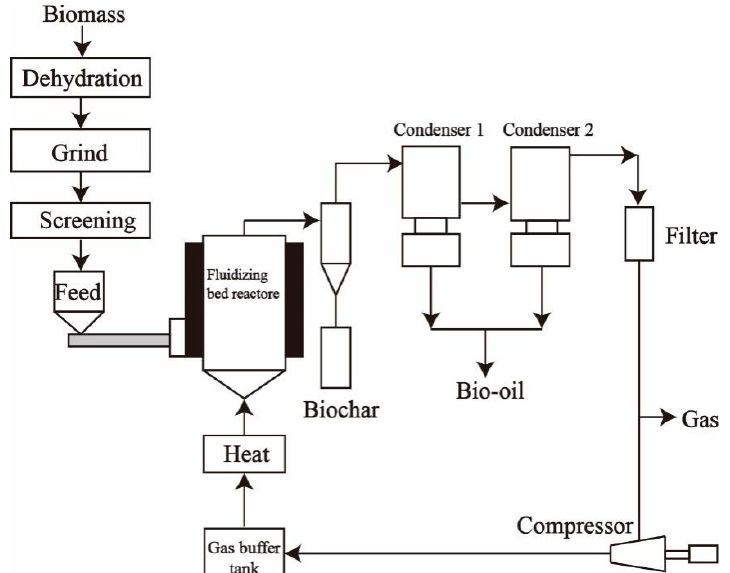
Figure 6. Schematic for the bubbling fluidized bed.